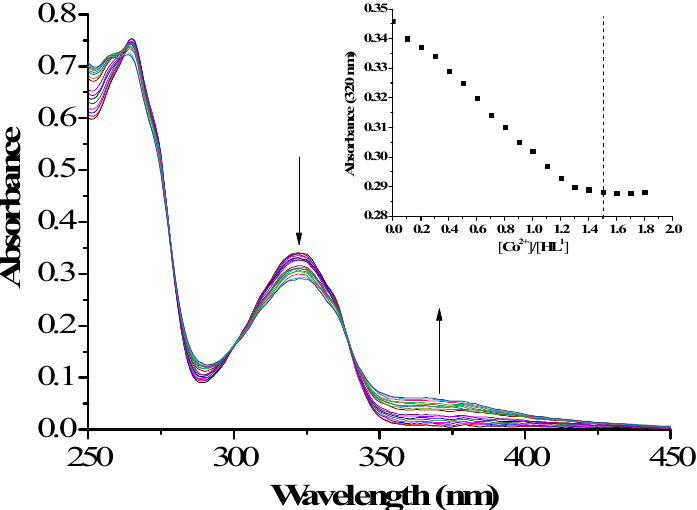
Figure 3. Ultra violet (UV)-Vis spectra of the changes in HL 1 upon addition of Co(OAc) 2 · 4H 2 O (Inset: the absorbance at 320 nm varies with the interaction of [Co 2+ ] / [HL 1 ]).